Question: Express in one sentence what the figure is showing.
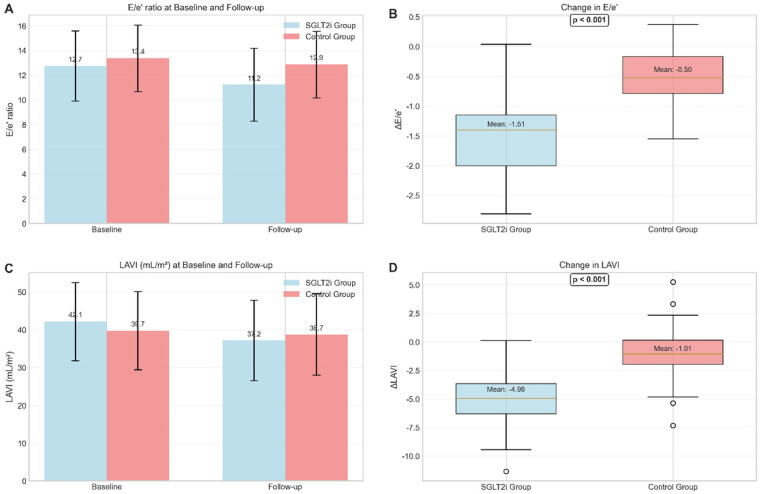
Answer: Changes in diastolic function parameters (E/e’ and LAVI). (A) Bar graph of the E/e’ ratio at baseline and follow-up in the two groups (mean ± SD). (B) Box-plot of the change in E/e’ ( Δ E/e’) in the SGLT2i and control groups. (C) Bar graph of the left atrial volume index (LAVI) at baseline and follow-up (mean ± SD). (D) Box-plot of the change in LAVI ( Δ LAVI). P -values were obtained from independent t-tests.